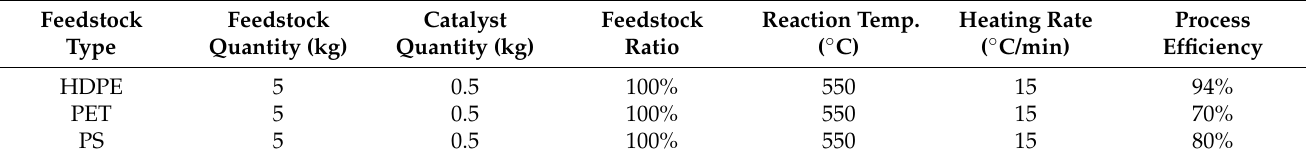
Table 1. Feedstock type and quantity